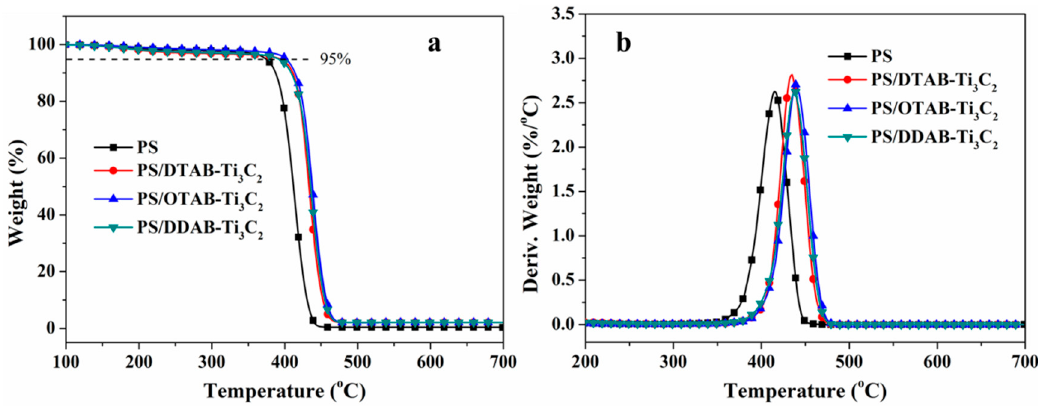
Figure 4. ( a ) TGA and ( b ) derivative thermogravimetry (DTG) curves of PS and its nanocomposites under nitrogen conditions. Table 1. TGA data of PS and PS nanocomposites under nitrogen conditions (20 °C/min, 5–10 mg; errors ± 0.5 wt%, ± 1 °C). T 5% = the temperature at 5% weight mass; T max = the temperature at the